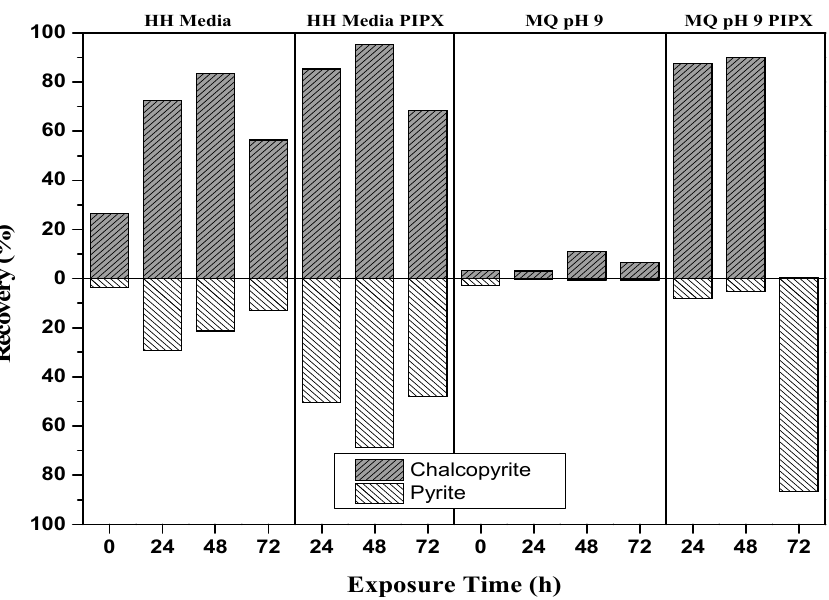
Figure 5. Baseline recoveries of Cp and Py as a function of time.